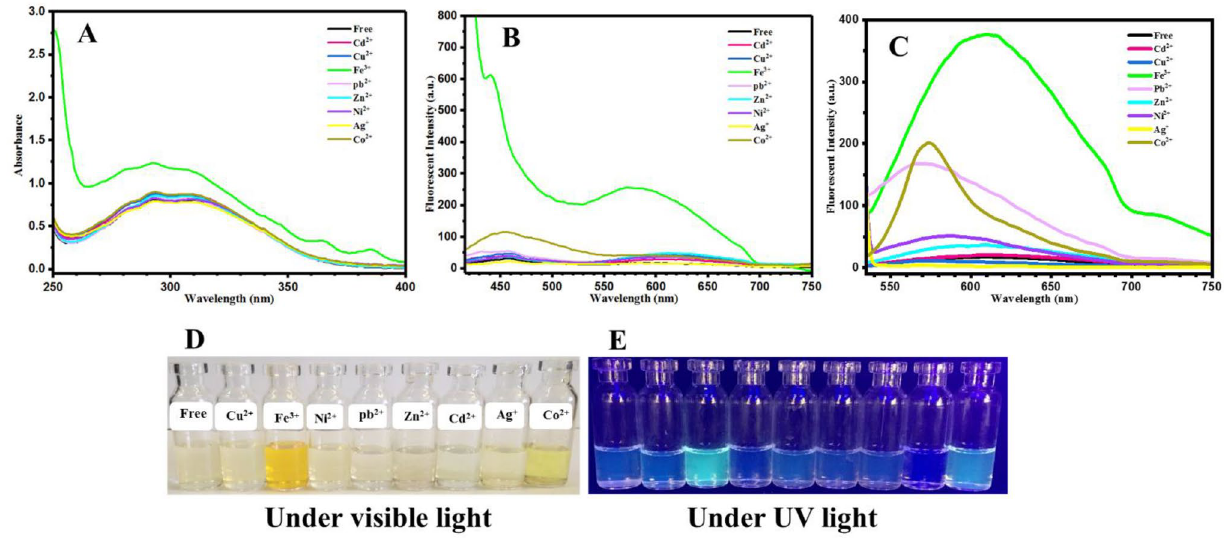
Figure 5. ( A ) UV–vis and ( B , C ) fluorescence spectra (excited at 400 and 520 nm, respectively) of the OX 2 - Nitro aqueous solutions with a concentration of 0.0002 M containing metal ions with a concentration of 0.01 M, and photographs of ( D ) color change and ( E ) fluorescence emission of the OX 2 -Nitro/metal ions solutions under visible light and UV irradiation,